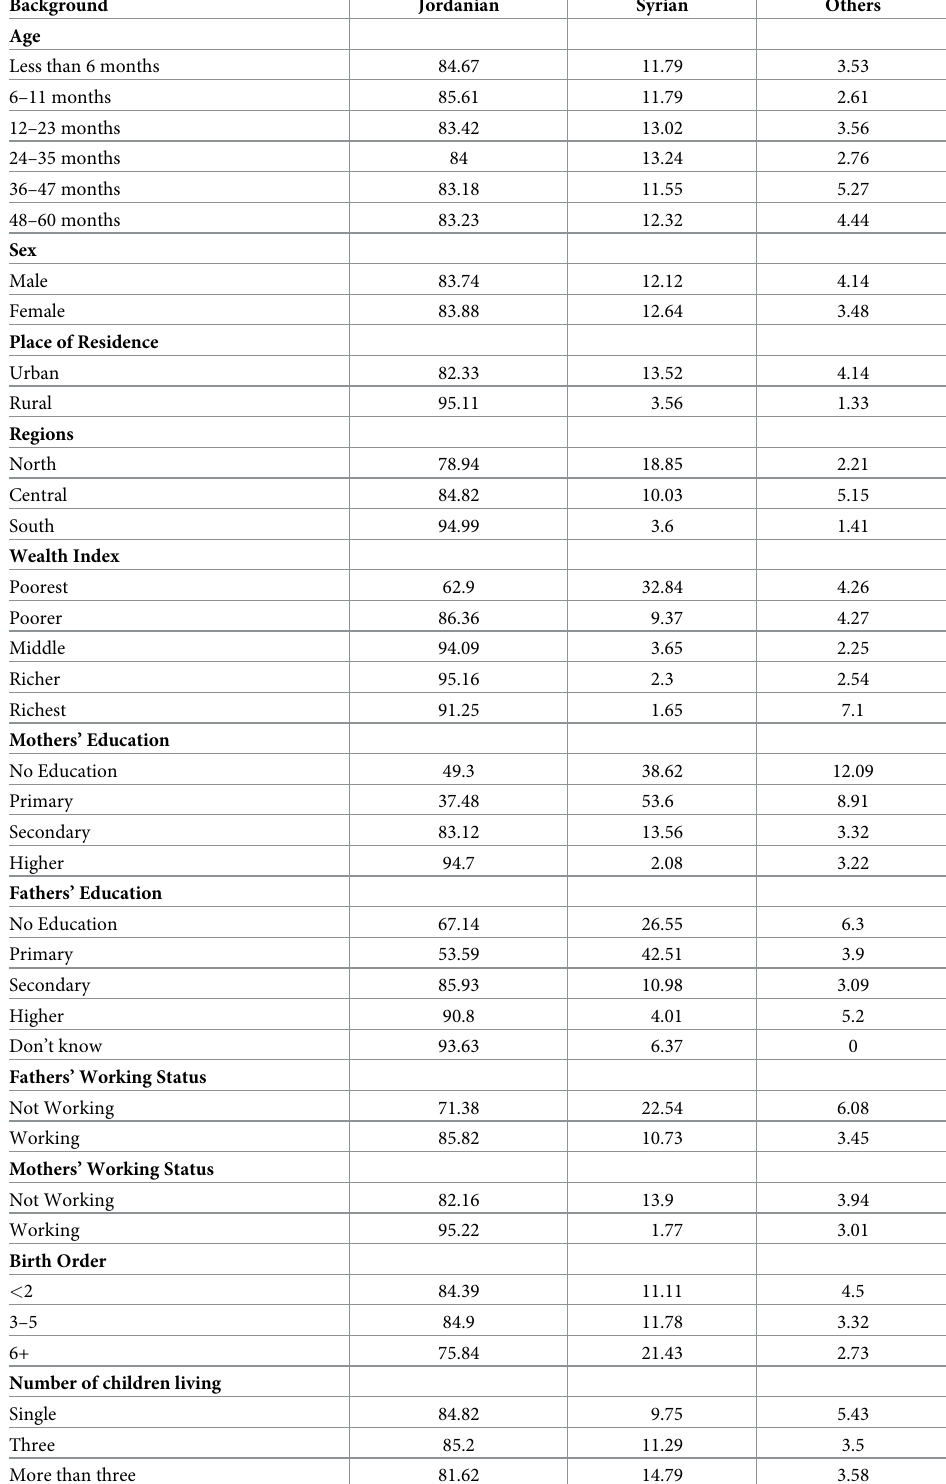
Table 1. Background characteristics by nationalities among under-five children in Jordan,